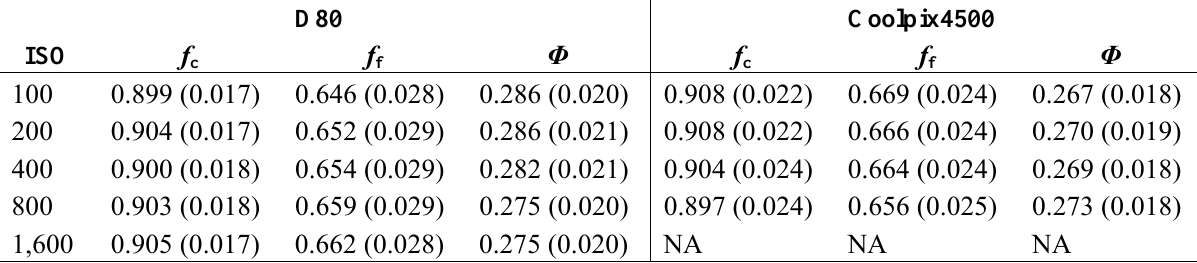
Table 5. Mean and standard error (in brackets) of crown cover ( f crown porosity ( Φ ) of 20 tree canopies, estimated from cover images collected at different ISO equivalence with the either the Nikon D80 DSLR or Coolpix 4500